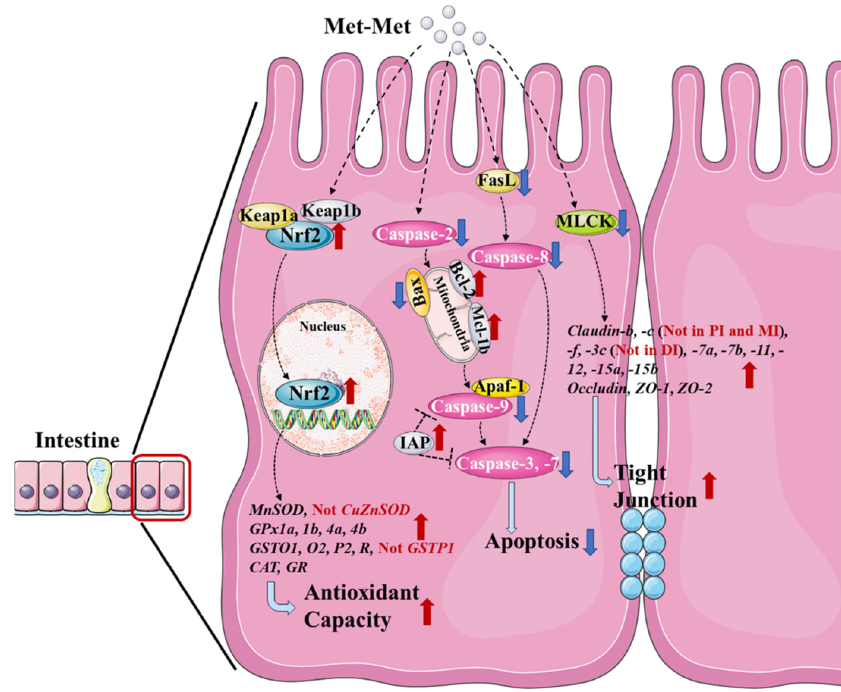
Figure 5. General summary for the effects of Met-Met on the intestinal physical barrier in fish.